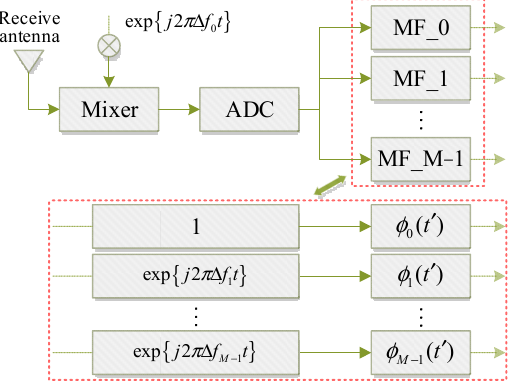
Figure 2. Signal processing flow at the receiver side.